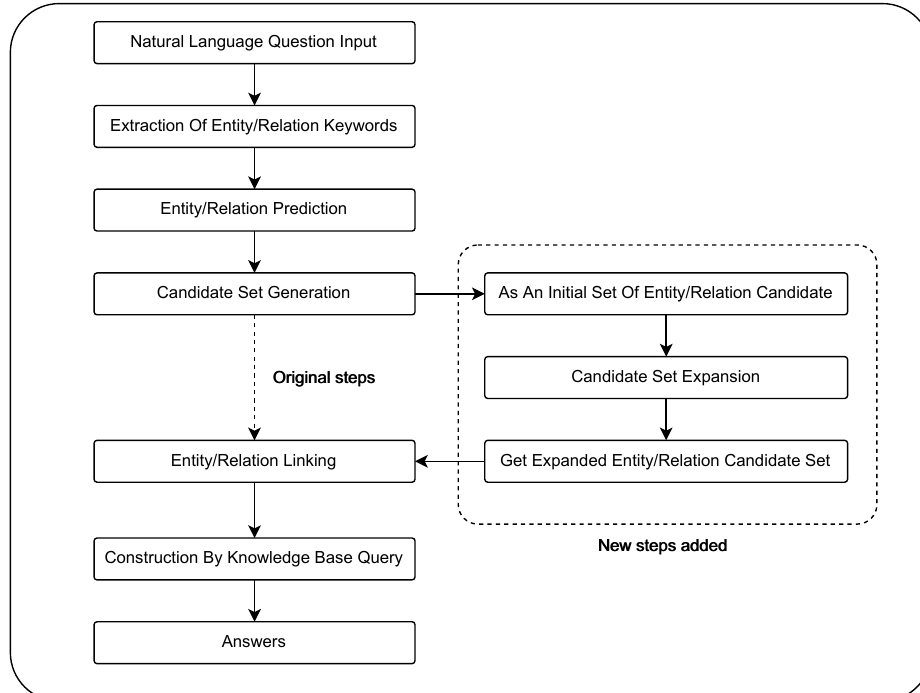
Figure 2. Relation-linking method for adding candidate set